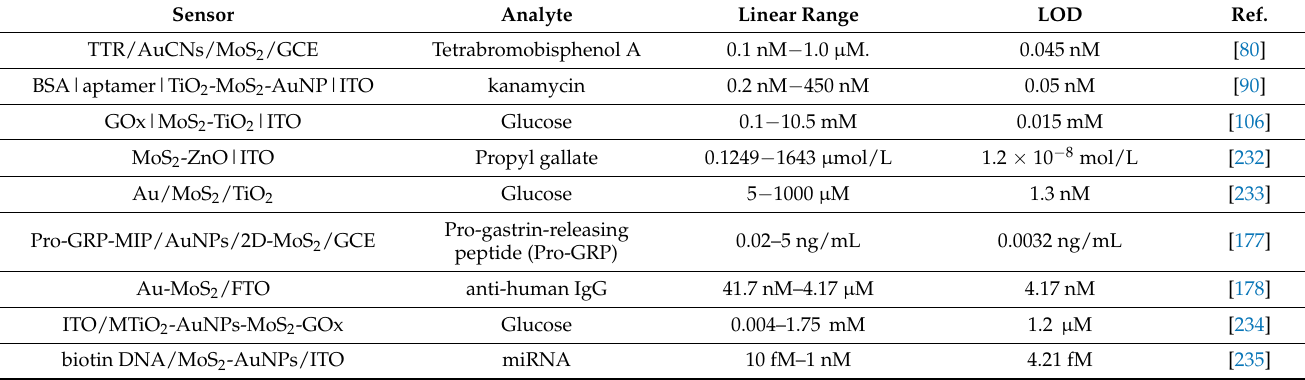
Table 4. Photoelectrochemical sensors based on 2D-MoS 2 /metal-NSs